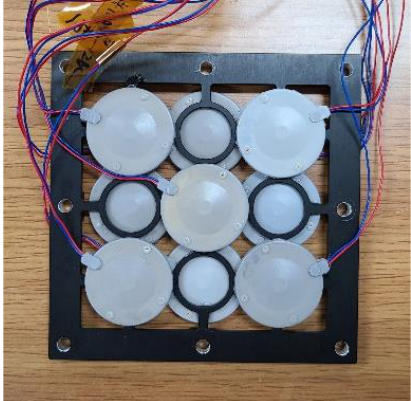
Figure 10. Photograph of the cymbal array specimen.